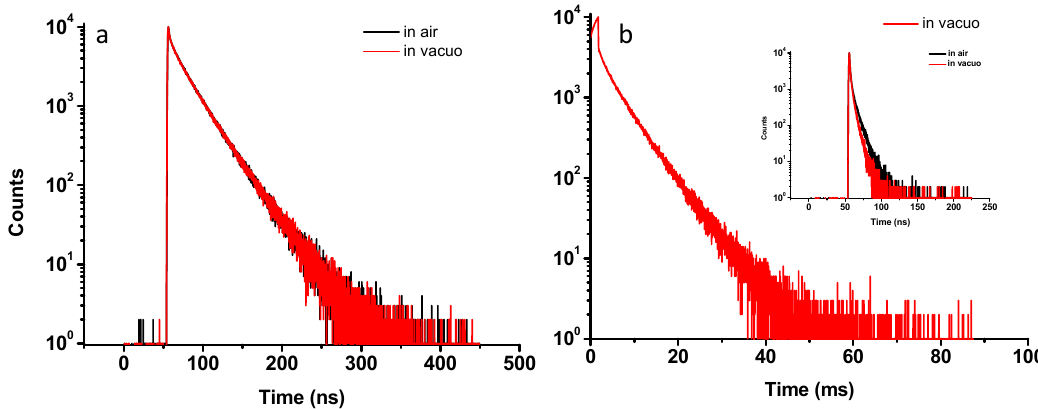
Figure 4. Photoluminescence lifetime decay ( λ ex = 374 nm) in air and in vacuo at 298 K: NI-PU3 (( a ) λ em = 456 in air and 457nm in vacuo) NIBr-PU3 (b, λ em = 568 nm in vacuo). Inset of ( b ): photoluminescence lifetime decay of NI-PU3 ( λ em = 426 in air and 420 nm in vacuo). Polymers 2017 , 9 , x FOR PEER REVIEW The optical energy gap ( Δ E g ) from onset of absorption decreases as the concentrations of dyes increase, which may be ascribed to dye-dye interaction in ground state (Figure 5c,d). To the best of our knowledge, the formation of excimers is due to interaction between excitons and ground-state molecules. Therefore, excimers don’t evidently change the absorption spectra of luminophores. As for the absorption spectra of NI-PU and NIBr-PU, the maximum absorption peaks are almost similar to each other (the absorption spectra of NI-PU emulsions are also similar, Figure S11), which means dye-incorporated WPUs have the same excited pathway. As a result, the appearance of the new bands (455 nm for NI-PU, 420 nm for NIBr-PU) could be attributed to the formation of the excimers.